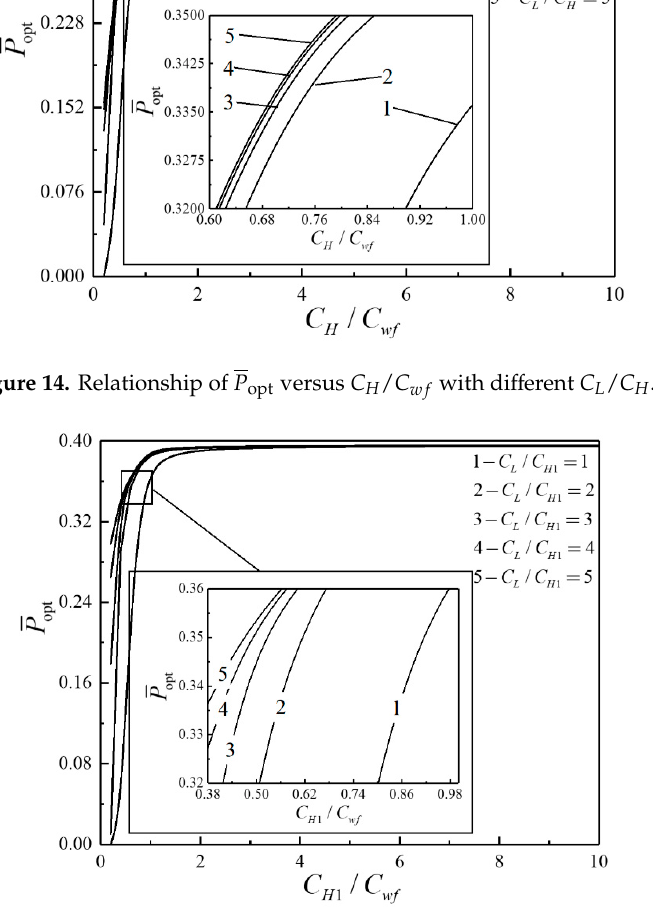
Figure 15. Relationship of P opt versus C H 1 / C wf with di